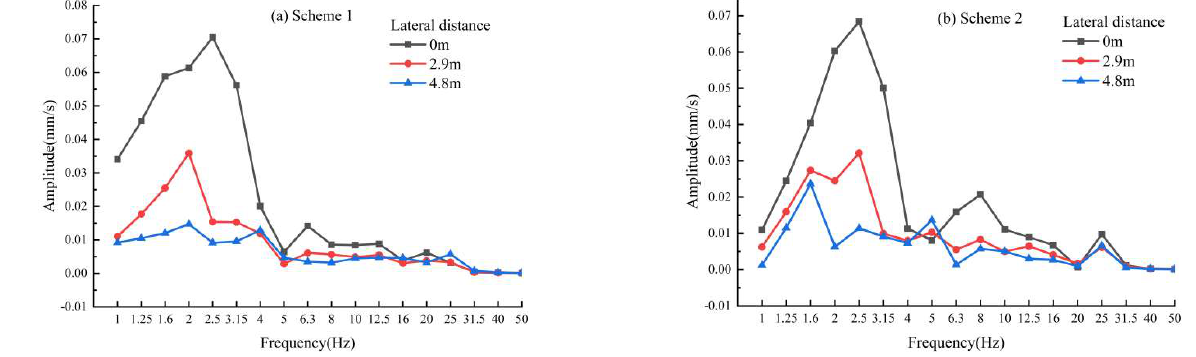
Figure 12. One-third frequency range analysis lateral decay curve.